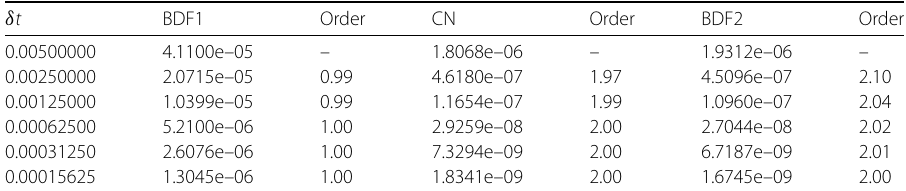
Table 2 The L 2 errors and orders at T = 0.05 for v that are computed by BDF1, CN, and BDF2 schemes δ t